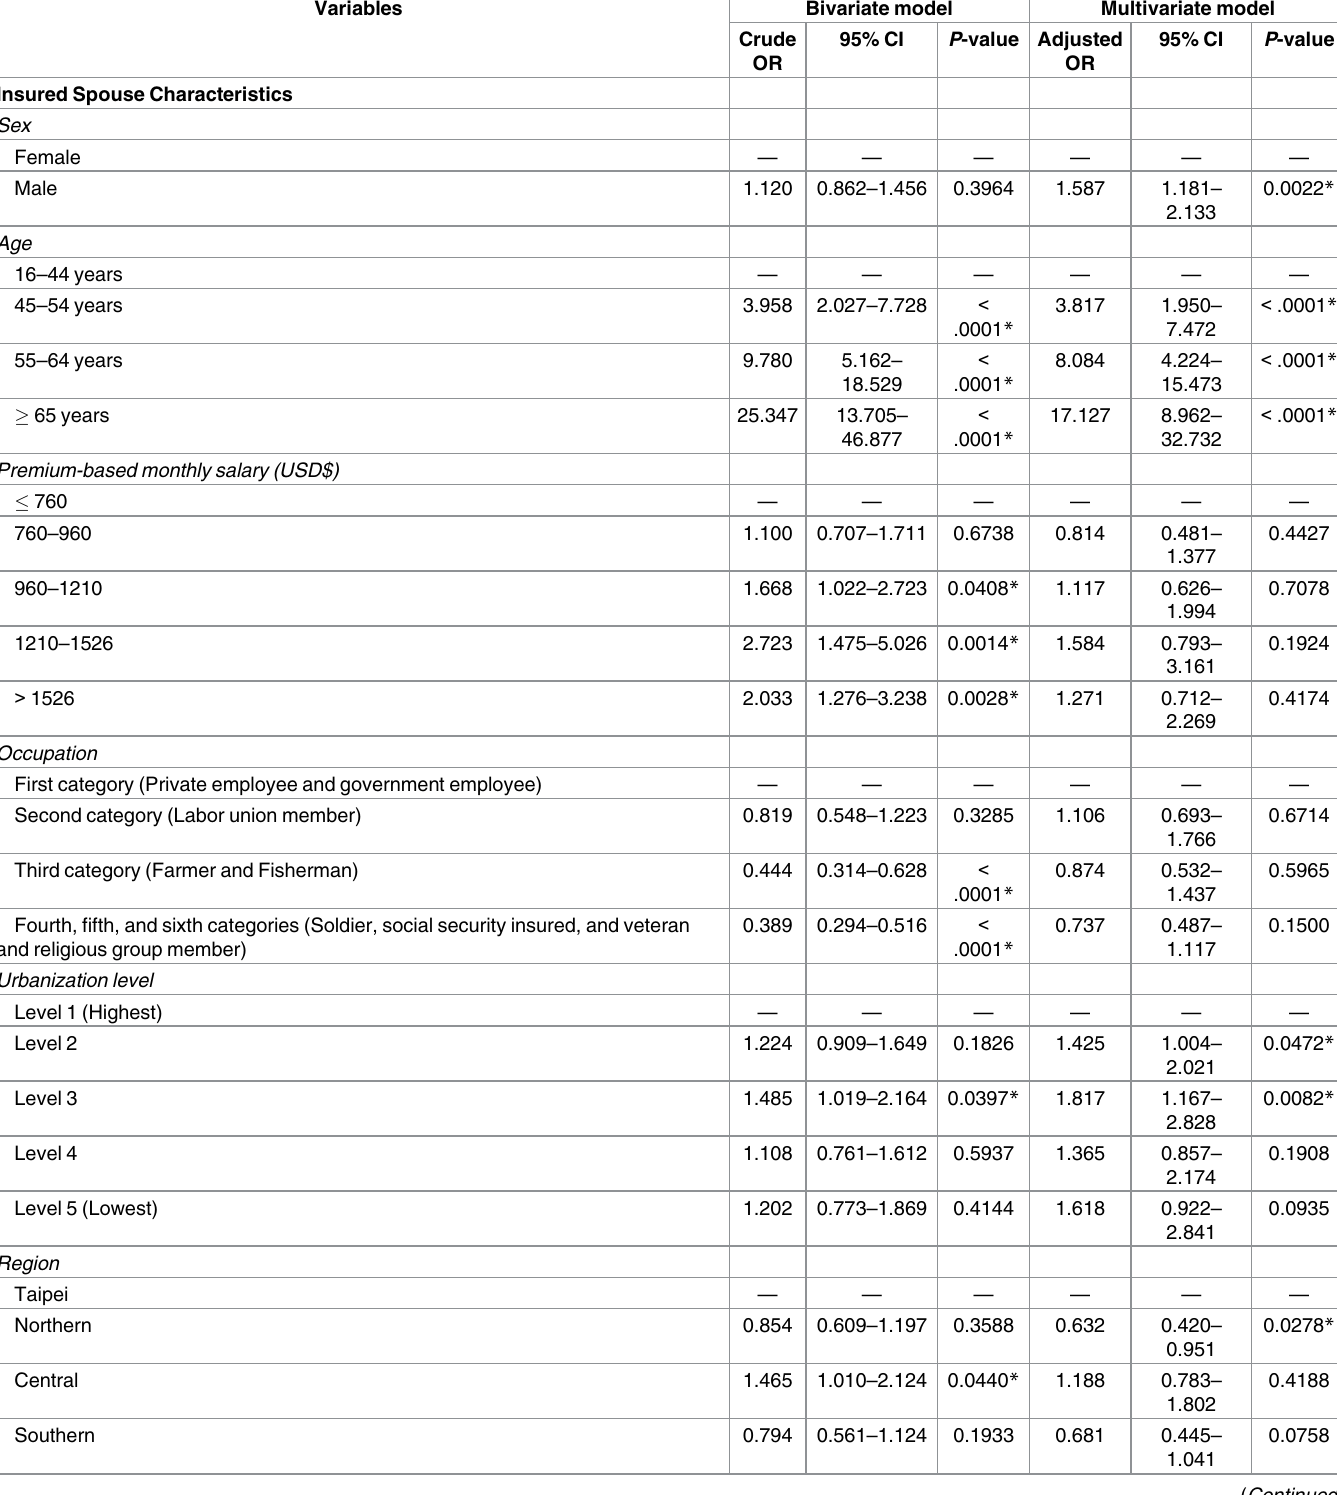
Table 4. Logistic regression models for spousal concordance during 2002–2013(N = 5,643